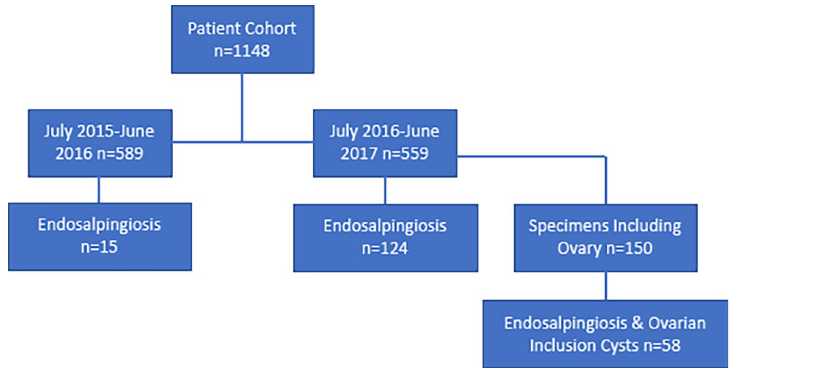
Fig 1. Flow diagram of tissue selection